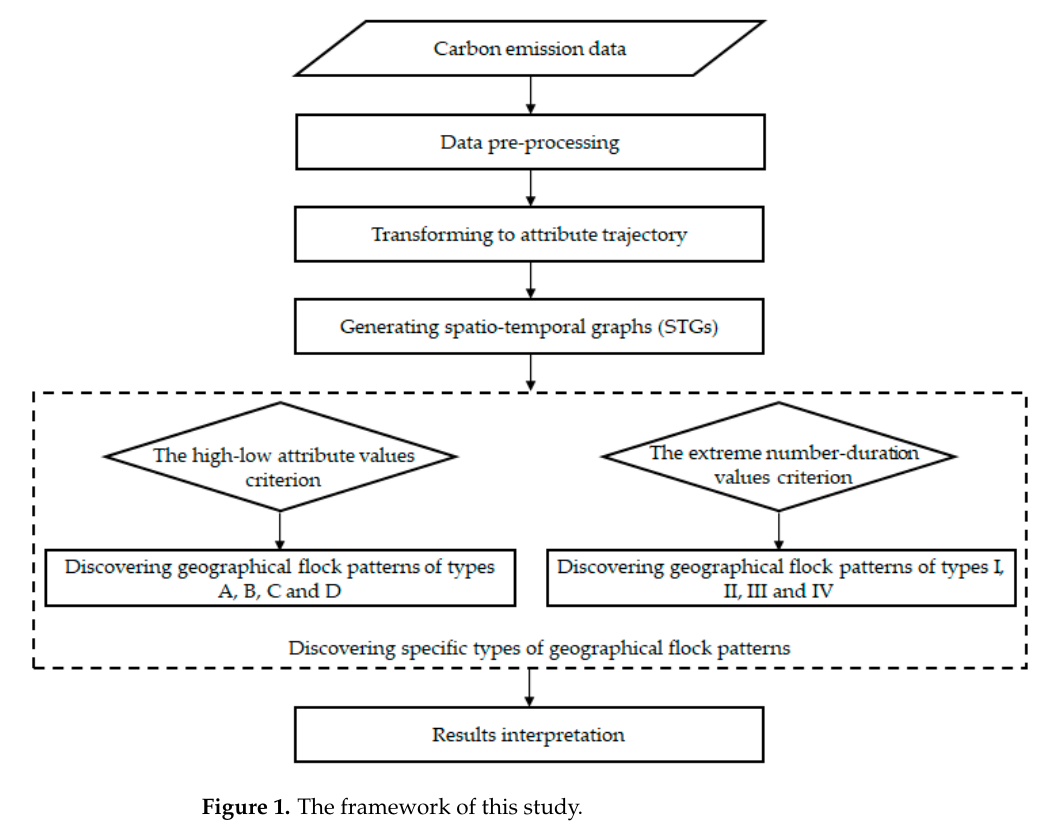
Figure 1. The framework of this study.